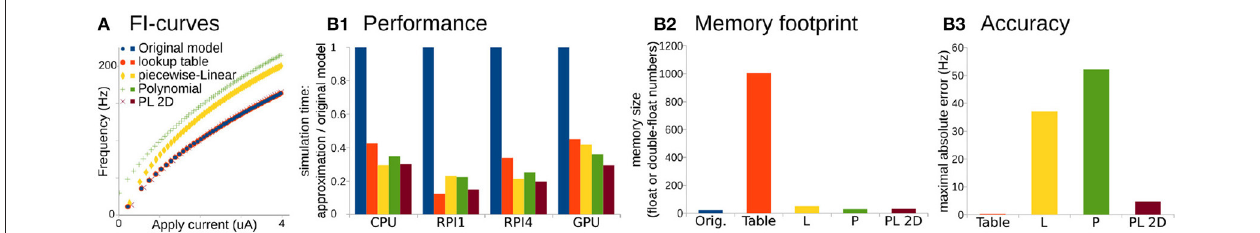
FIGURE 2 | Comparison of original Wang and Buzsáki model with different approximations. (A) FI-curves, used for accuracy assessment. (B1) Performance Of 3D lookup table (red), 3D piecewise-Linear (L, yellow), 3D Polynomial (P, green), and 2D Polynomial+piecewise-Linear approximations (PL2D, brown) in comparison with the original 3D model (blue) computed on four different platforms: CPU —Intel Core i5-5257U, RPI1 —Raspberry Pi 1, RPI4 —Raspberry Pi 4, and GPU —NVidia GeForce RTX 2080 Ti. (B2) Assessment of memory size needed for model constants in the total number of single, double, or long double precision numbers. (B3) Standard squared error between FI-curve of the original model and four different approximations.